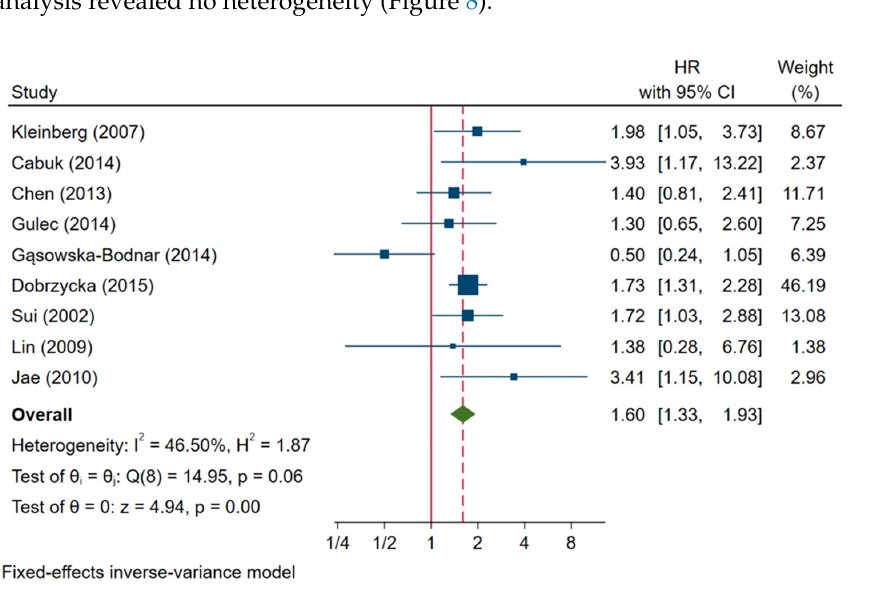
Figure 8. Impact of survivin expression on overall survival [3,23,26–29,34,38].